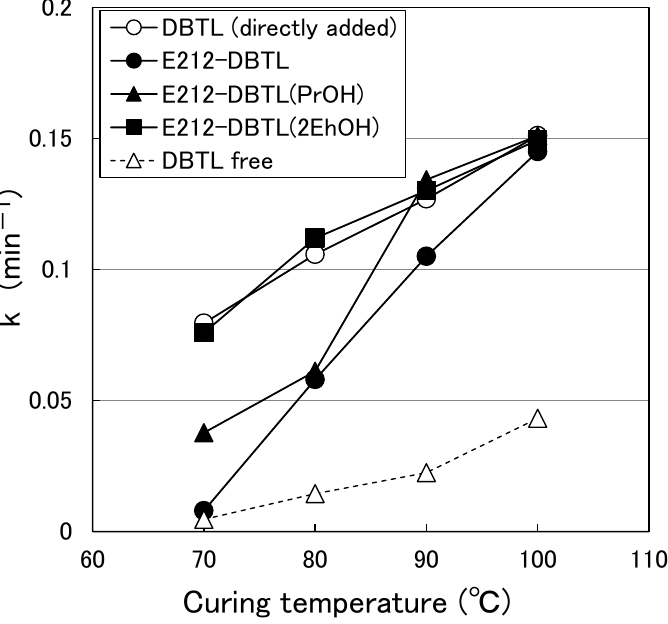
Figure 4. Relationship between the curing speed constant (k) and curing temperature and the effects of the organic solvent on the curing behavior.